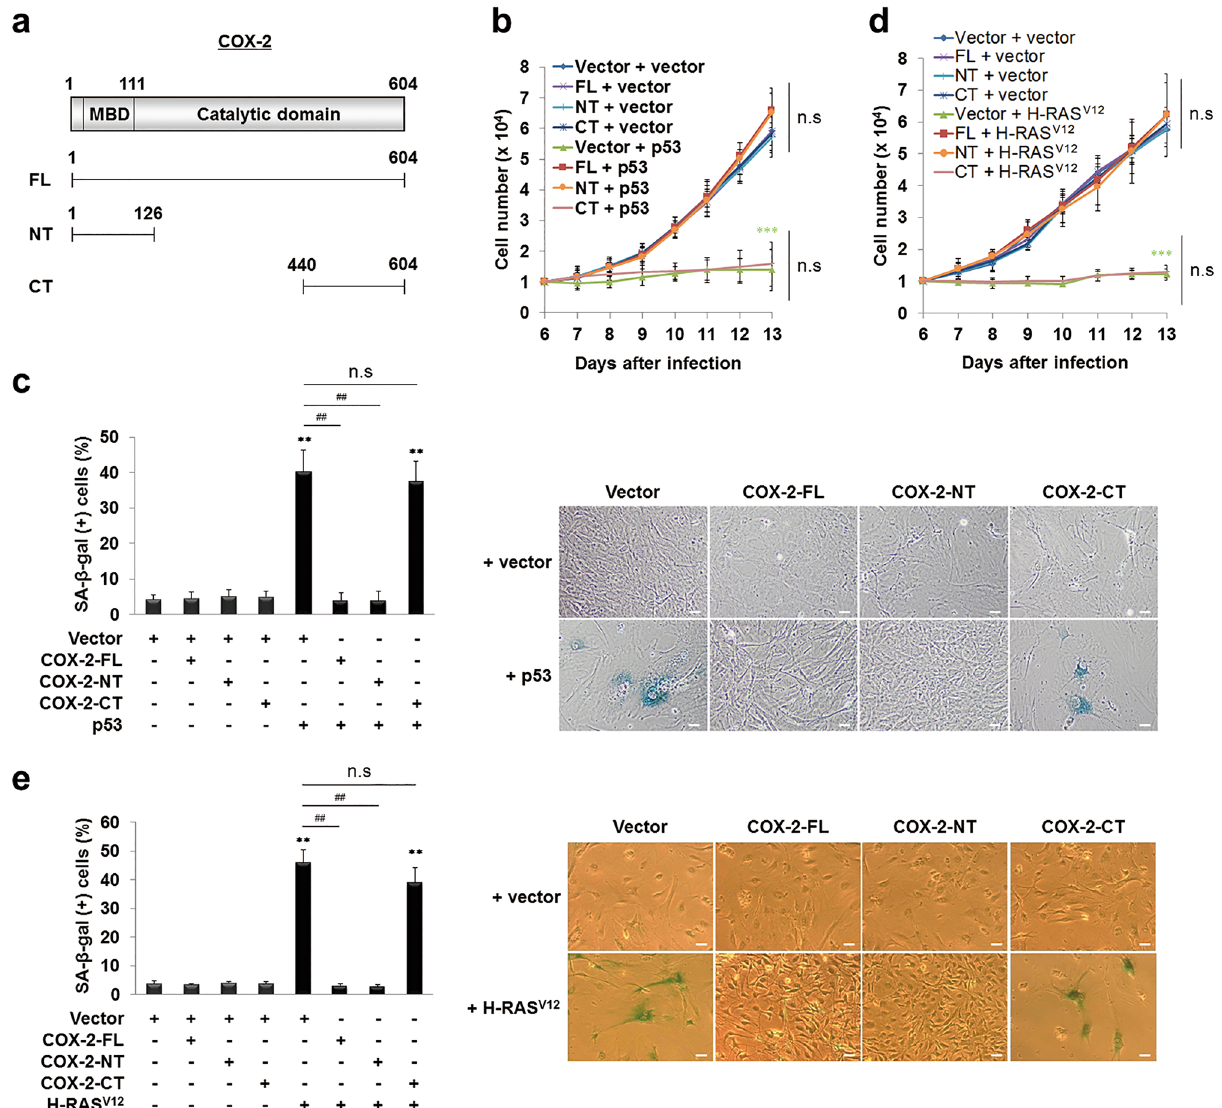
Figure 6. COX-2 inhibits the pro-senescent function of p53 and OIS by physical interactions with p53. ( a ) Schematic representation of the structure of human COX-2 and its deletion mutants (MBD, the membrane- binding domain). ( b , d ) MEFs were infected with retroviruses as indicated. 1 × 10 4 cells were seeded and the number of cells was counted. Data are means ± SD ( n = 10 in ( b ) and n = 8 in ( d )) (*** P < 0.001 vs. Vector + vector; n.s, not significant at the final day). ( c , e ) SA-β-gal (+) cell ratios were calculated (left) and the representative data were shown (right). Data are means ± SE ( n = 12; ** P < 0.01 vs. Vector; ## P < 0.01; n.s, not significant). Scale bars = 13.6